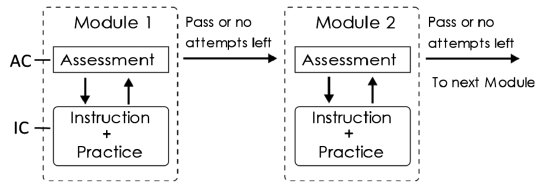
FIG. 1. Schematic illustration of the design of online learning module. Two modules in a sequence are